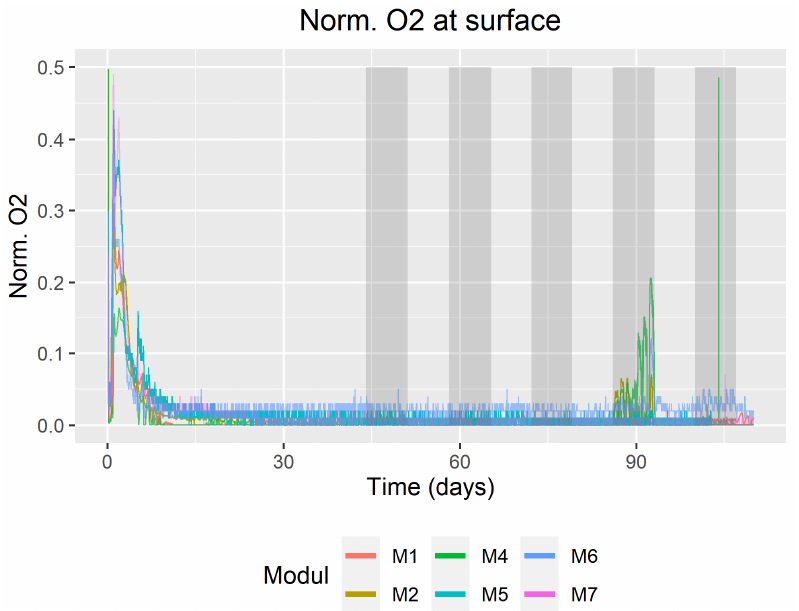
Figure 10. Normalized oxygen content during the full-scale test within the trial field. Grey highlighted are the days of air breaches. At the beginning of the trials, an unusual rise in the oxygen curve can be observed which can be traced back to a cross sensitivity to NOx gases. Breaches 1–3 and 5 are at spot A, and breach 4 is at spot B (Figure 2). During the air breaches, several sensors showed a rise in their curves and therefore indicate an air breach. When no abnormality is present, the values are pending close to zero. As Module 8 broke within the first few days, it is not shown.